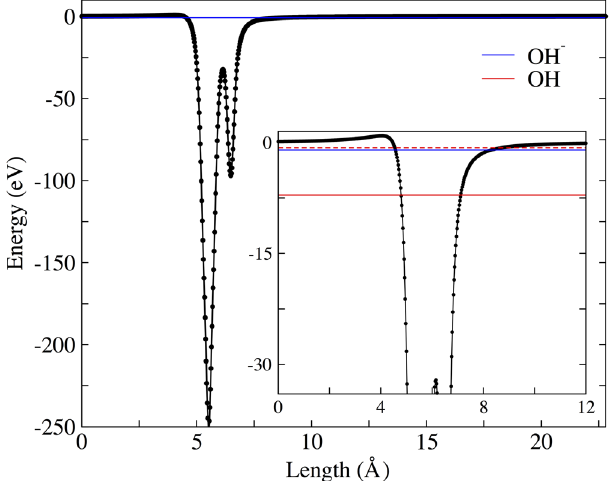
FIG. 11. Convergence challenge for the OH − radical producing potential density-driven DFT errors. The instability here is driven by SIE effects [89], and the potential error is evident by noting a closeness of the highest-occupied molecular orbital (HOMO) energy position and the vacuum level, i.e., the zero-energy value. Convergence of negatively charged ions and radicals is a challenge not only in this CX calculation but for all XC functionals (even hybrids [17]) since we seek a proper size convergence and therefore push our plane-wave calculations close to the complete-basis-set limit [89]. The figure shows the self-consistently computed electrostatic potential along a ray containing the nuclei (potential dips) and OH − bonding region. The QE approximation for the vacuum level is found at the plateau value, here located just above the OH − HOMO level (solid blue horizontal bar). The inset provides a closer look, showing the potential barriers surrounding the molecular regions and tracking differences between the neutral OH lowest-unoccupied molecular level (broken red bar) and the OH − HOMO